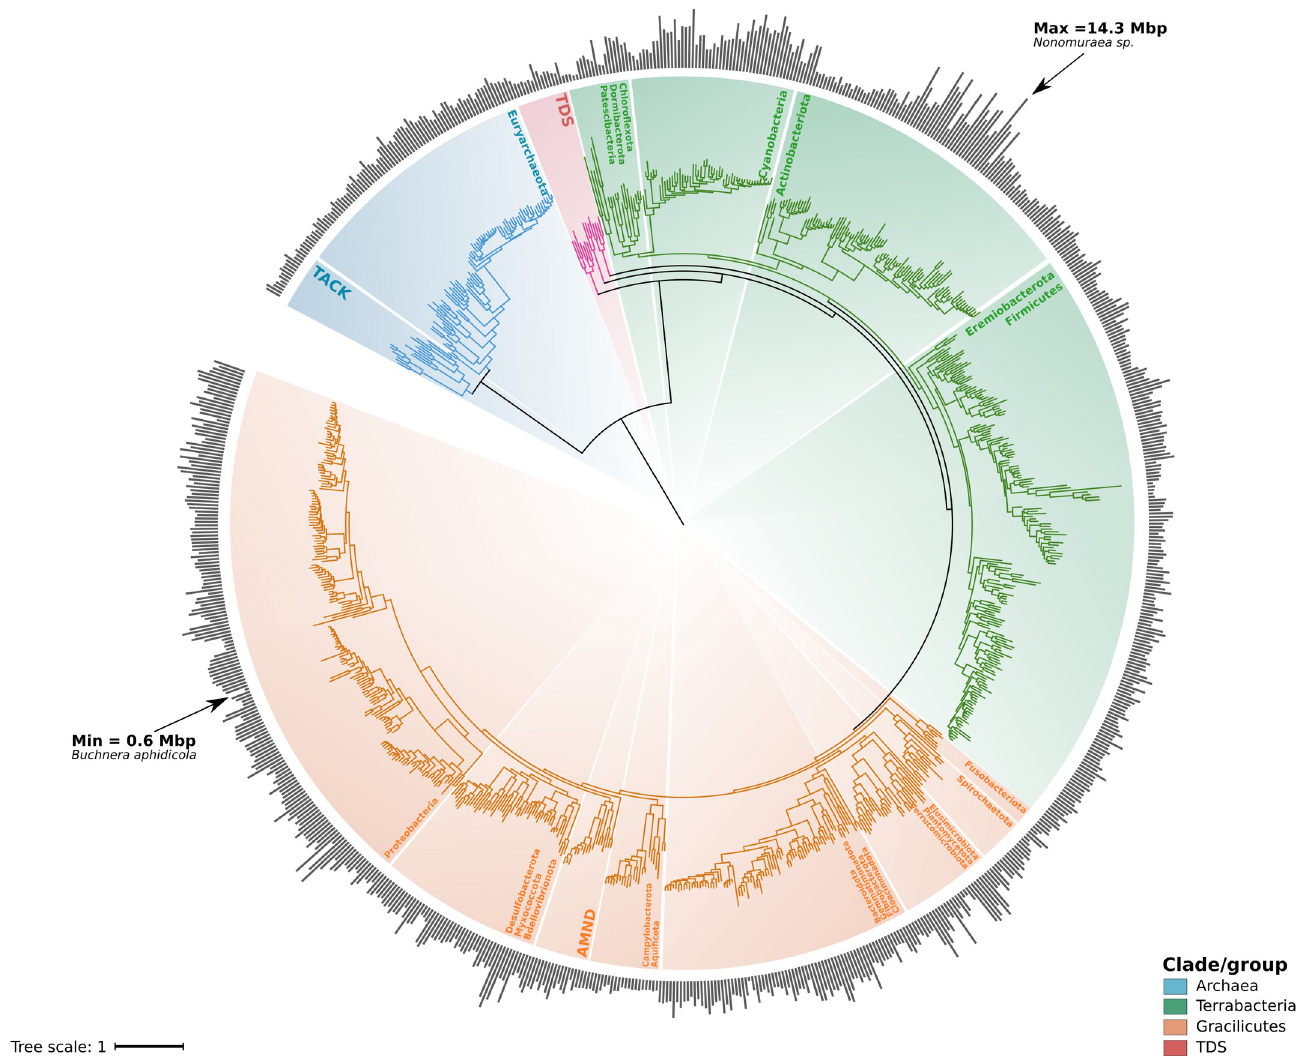
Fig 2. Genome size distribution across the Tree of Life of bacteria and archaea using one representative genome for each genus. Phylogenetic tree was built using a concatenated alignment of ribosomal and RNA polymerase sequences through a maximum likelihood approach and the substitution model LG+R10. Abbreviations: TACK = Thaumarchaeota, Aigarchaeota, Crenarchaeota and Korarchaeota; TDS = Thermotogota, Deinococcota, and Synergistota; AMND = Acidobacteriota, Methylomirabilota, Nitrospirota, Deferribacterota. Raw data for genome size can be found in S2 Data.